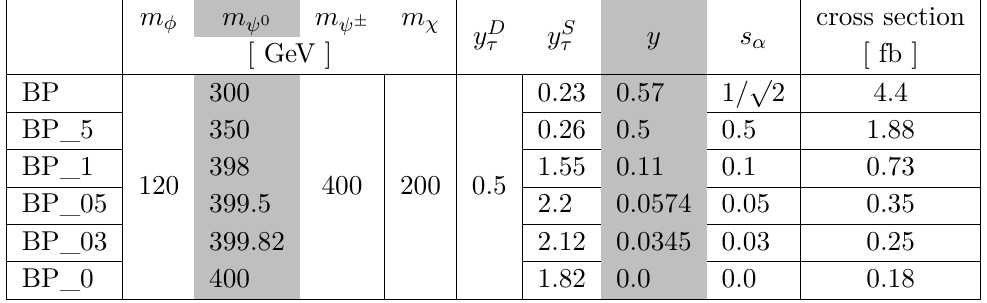
Table 4 . Relic density allowed benchmark points for analysis of ‘ τ 2 ν 2 φ channels. y D 10 − 9 . The shaded columns are for the dependent model